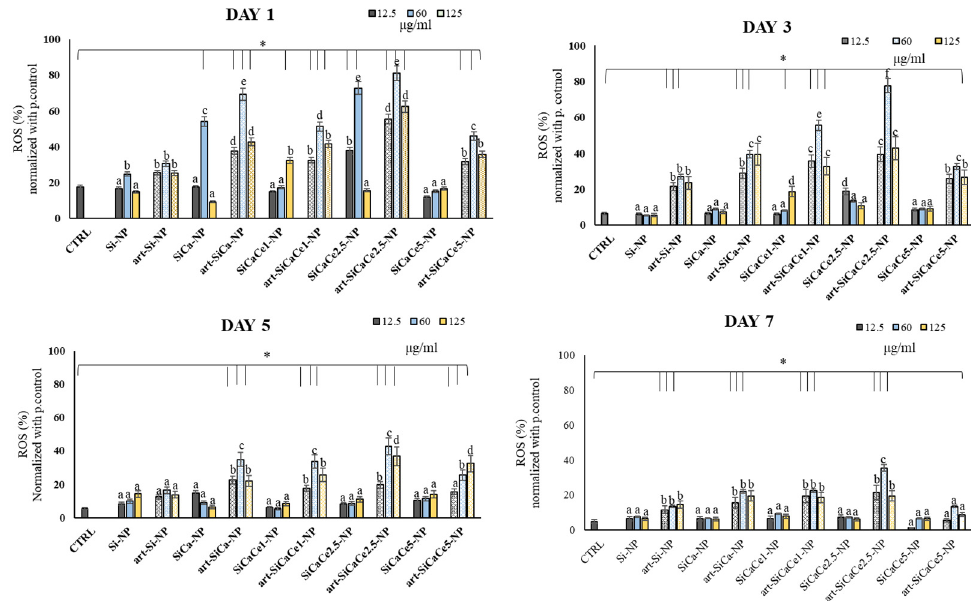
Figure 9. Extracellular ROS (%) levels after 1, 3, 5 and 7 days of different concentrations (12.5, 60, 125 μ g/mL)) of NPs in contact with hPDLFs. The lines with * above bars indicate statistically significant differences ( p < 0.05) of ROS % among the treated cells with the different NPs and concentrations and the untreated cells (controls), while different letters above bars suggest statistically significant differences ( p < 0.05) of ROS % among the cells treated with different concentrations of NPs. Same letters above the bars suggest that ROS production did not differ significantly among the specific NPs and associated